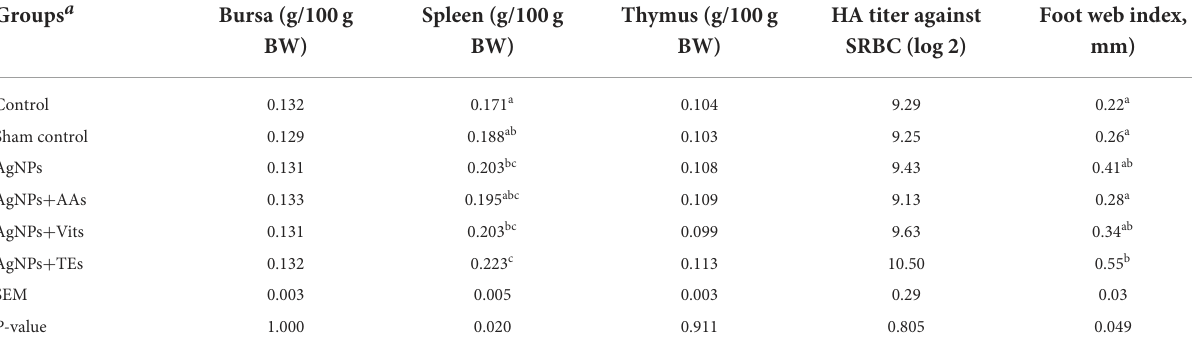
TABLE 3 Effect of in ovo administration of silver nanoparticles (AgNPs) and critical nutrients on the weight of immune organs in broiler chickens. Groups